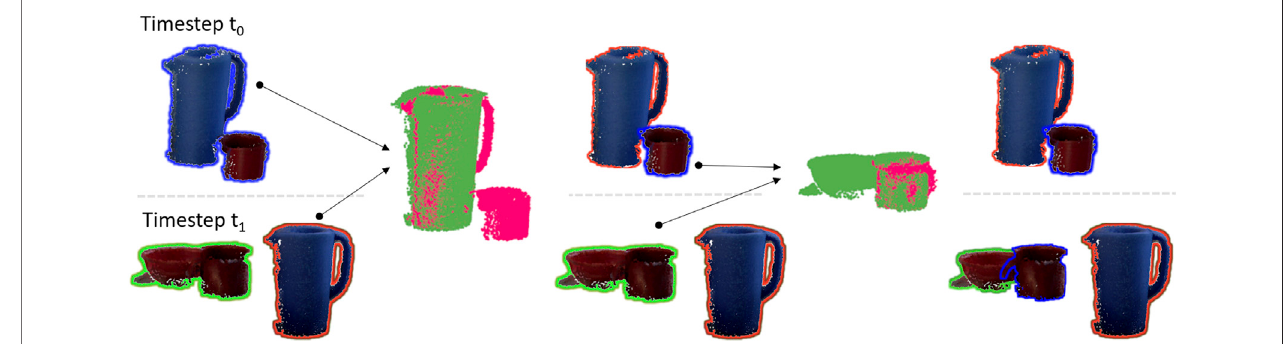
FIGURE 3 | Example showing how objects are separated using PPF matching. Objects next to each other having the same shadow color are recognized as one object by the robot. After objects are matched they have the same shadow color in both recordings.